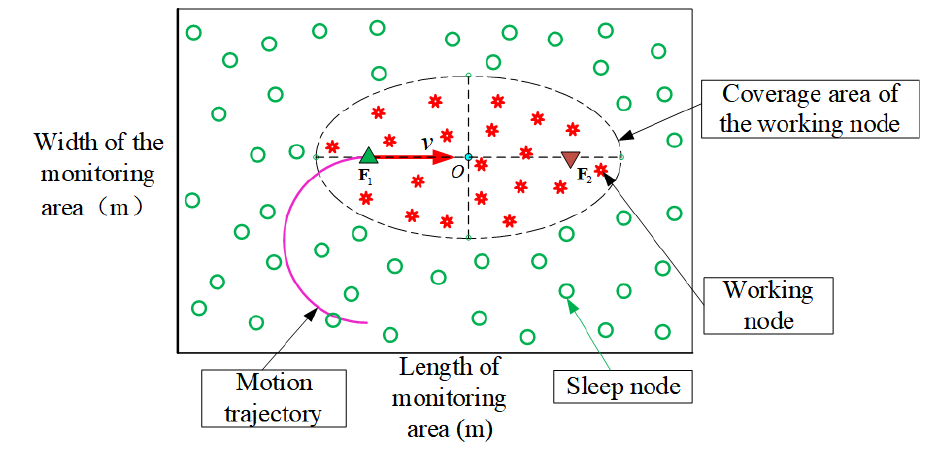
Figure 3. Distribution of working nodes and sleep